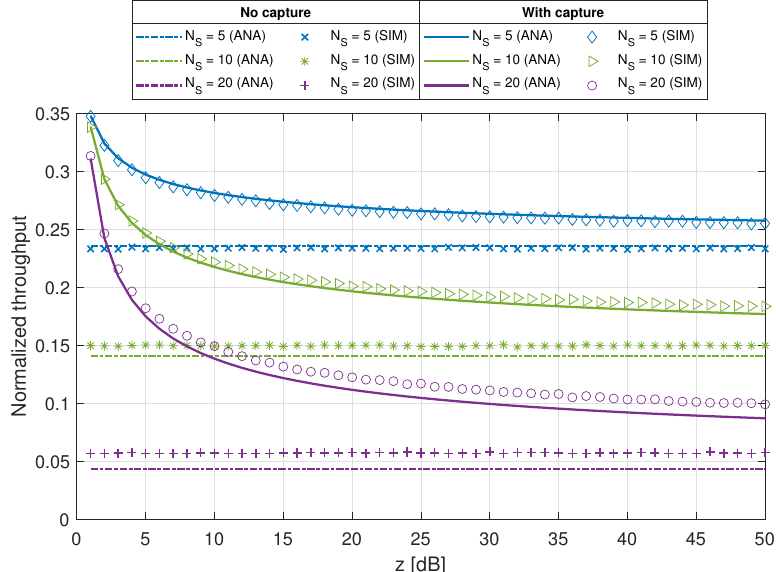
Figure 13. Impact of the capture threshold and the number of stations assigned to the RAW